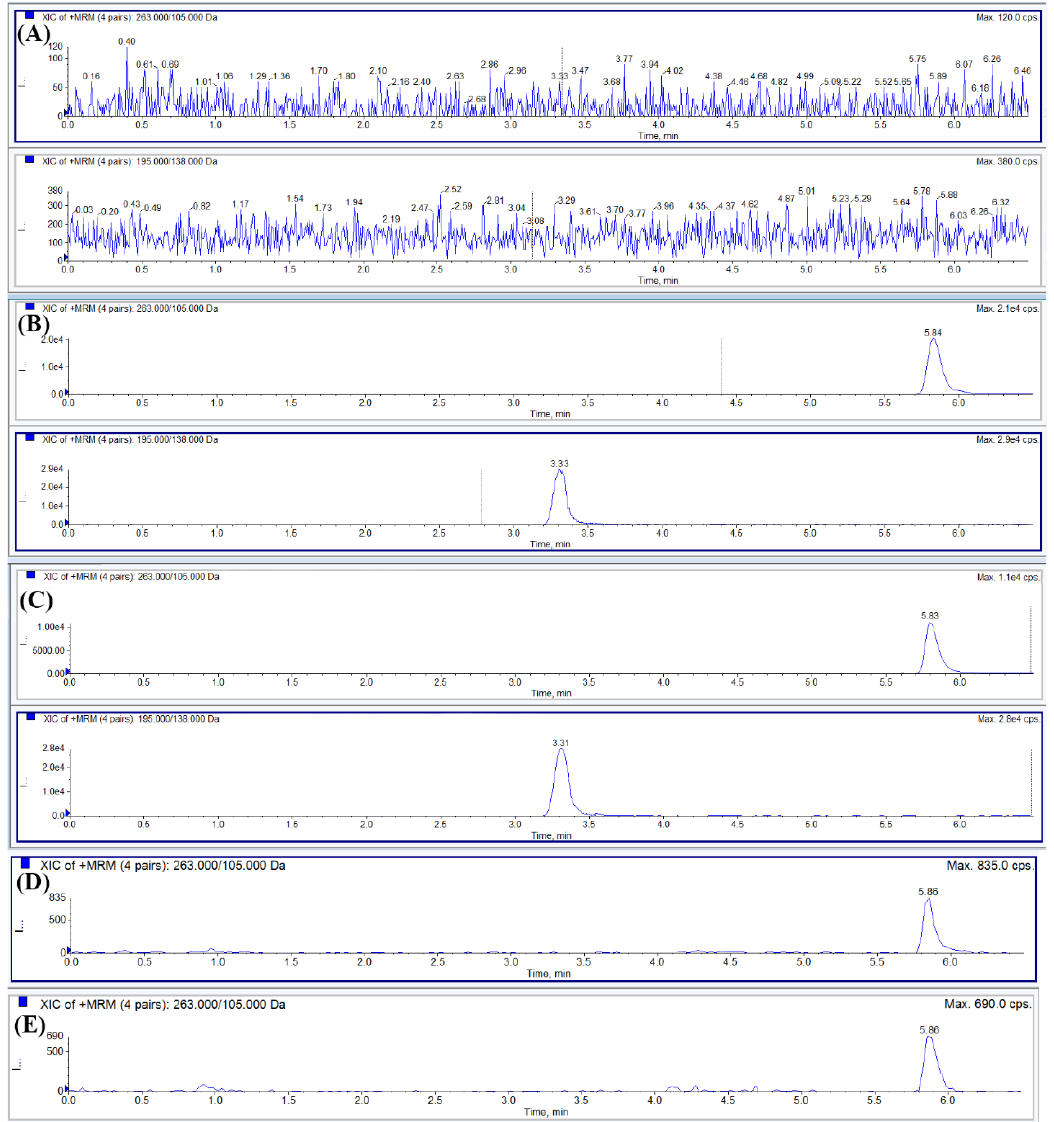
Figure 2. Representative chromatograms of: ( A ) alnustone (5.84 min) and IS (3.33 min) obtained by the extraction of blank plasma; ( B ) blank plasma spiked with alnustone and IS; ( C ) plasma sample from a rat 2h after an intravenous administration of alnustone (5 mg/kg) to rats; ( D ) blank liver tissue homogenates spiked with alnustone at LLOQ; ( E ) blank plasma spiked with alnustone at LLOQ.